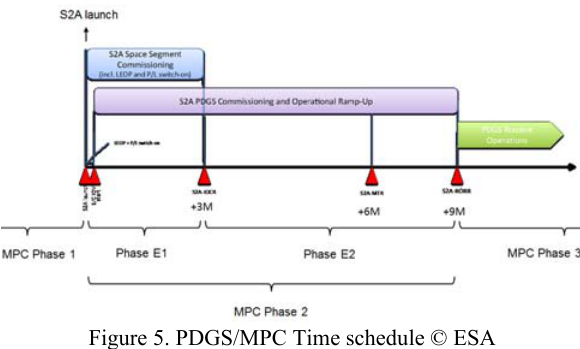
Figure 5. PDGS/MPC Time schedule ©